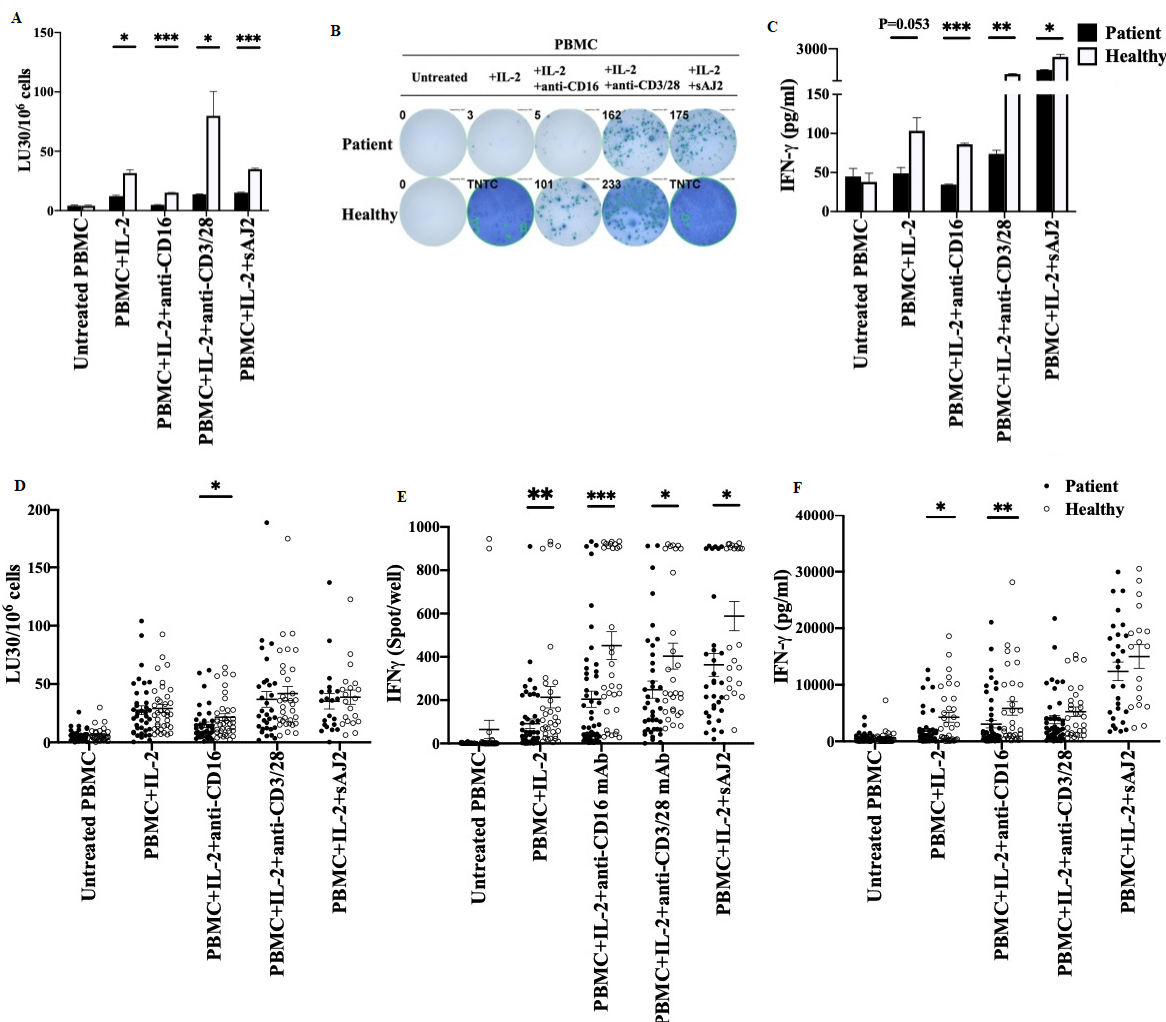
Figure 1. Peripheral blood mononuclear cells obtained from cancer patients exhibited lower NK cell-mediated cytotoxicity and IFN- γ secretion. PBMCs were isolated from cancer patients’ and those of the healthy individuals’ peripheral blood as described in Materials and Methods section. PBMCs were left untreated or treated with IL-2 (1000 U/mL) or with a combination of IL-2 (1000 U/mL) and anti-CD16 mAbs (3 µg/mL), or with a combination of IL-2 (1000 U/mL) and anti-CD3/28 mAbs (25 µL/mL), or with a combination of IL-2 (1000 U/mL) and sAJ2 (PBMC:sAJ2, 1:20) for 18 h before using in functional assays. NK cell-mediated cytotoxicity of PBMCs was determined using standard 4 h 51 Cr release assay against OSCSCs. Lytic units (LU) 30/10 6 cells were determined using inverse number of PBMCs required to lyse 30% of OSCSCs × 100 ( A , D ). Number of cells secreting IFN- γ in PBMCs were determined as spot counts using ELISpot assay ( B , E ). Supernatants were harvested from PBMCs and the secretion of IFN- γ were determined using ELISA ( C , F ). A representative experiment is shown in ( A – C ) and the data are presented as Mean ± SD. Compiled data are shown in ( D – E ) ( n = 20 to 49), and the data are presented as Mean ± SEM. Student t tests were performed. *** ( p value < 0.001), ** ( p value 0.001–0.01), * ( p value 0.01–0.05).